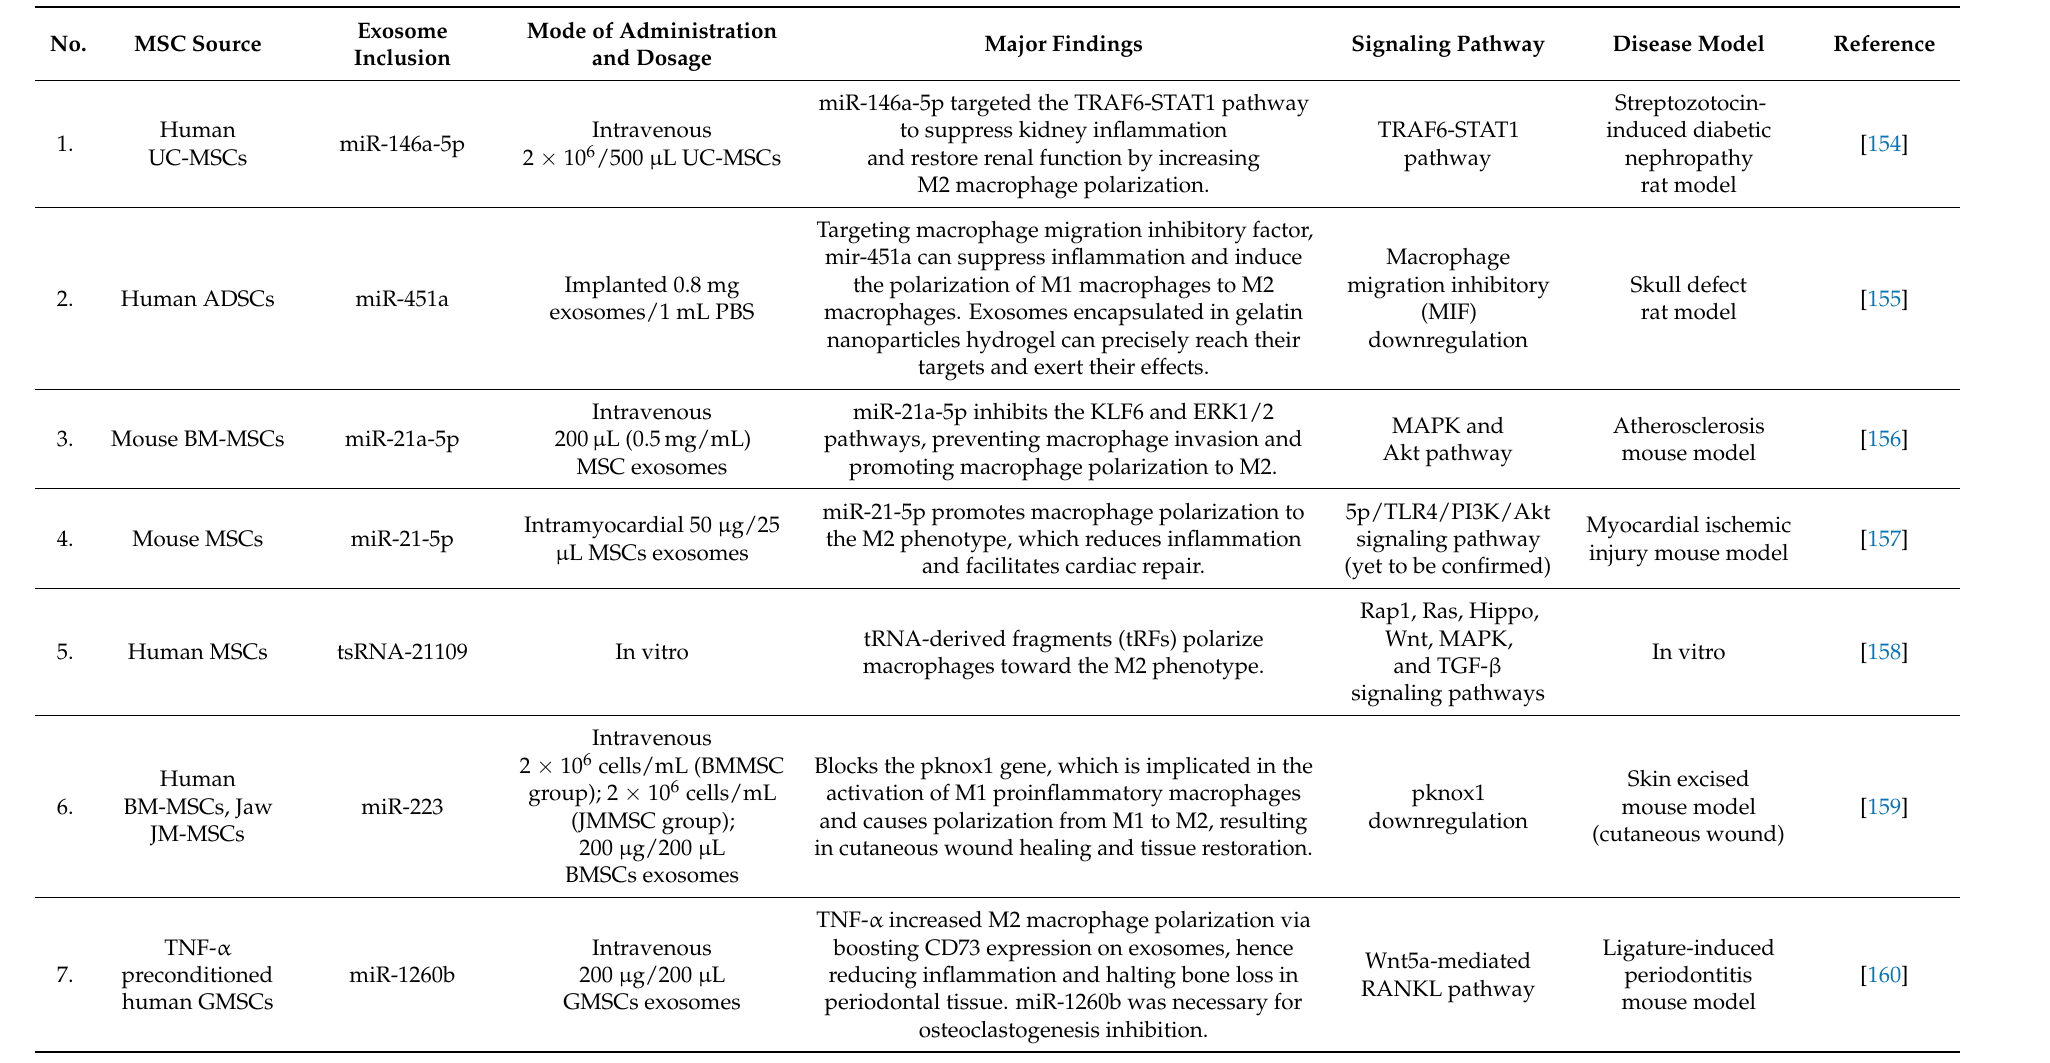
Table 2. MSC-derived exosomes polarize macrophages to decrease inflammation in various inflammation